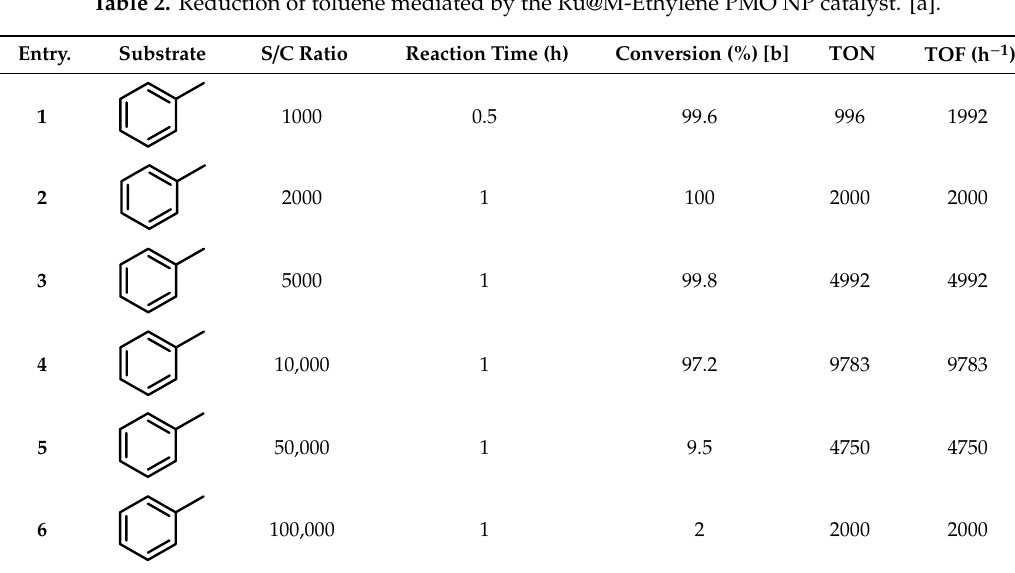
Table 2. Reduction of toluene mediated by the Ru@M-Ethylene PMO NP catalyst. [a]. Entry.